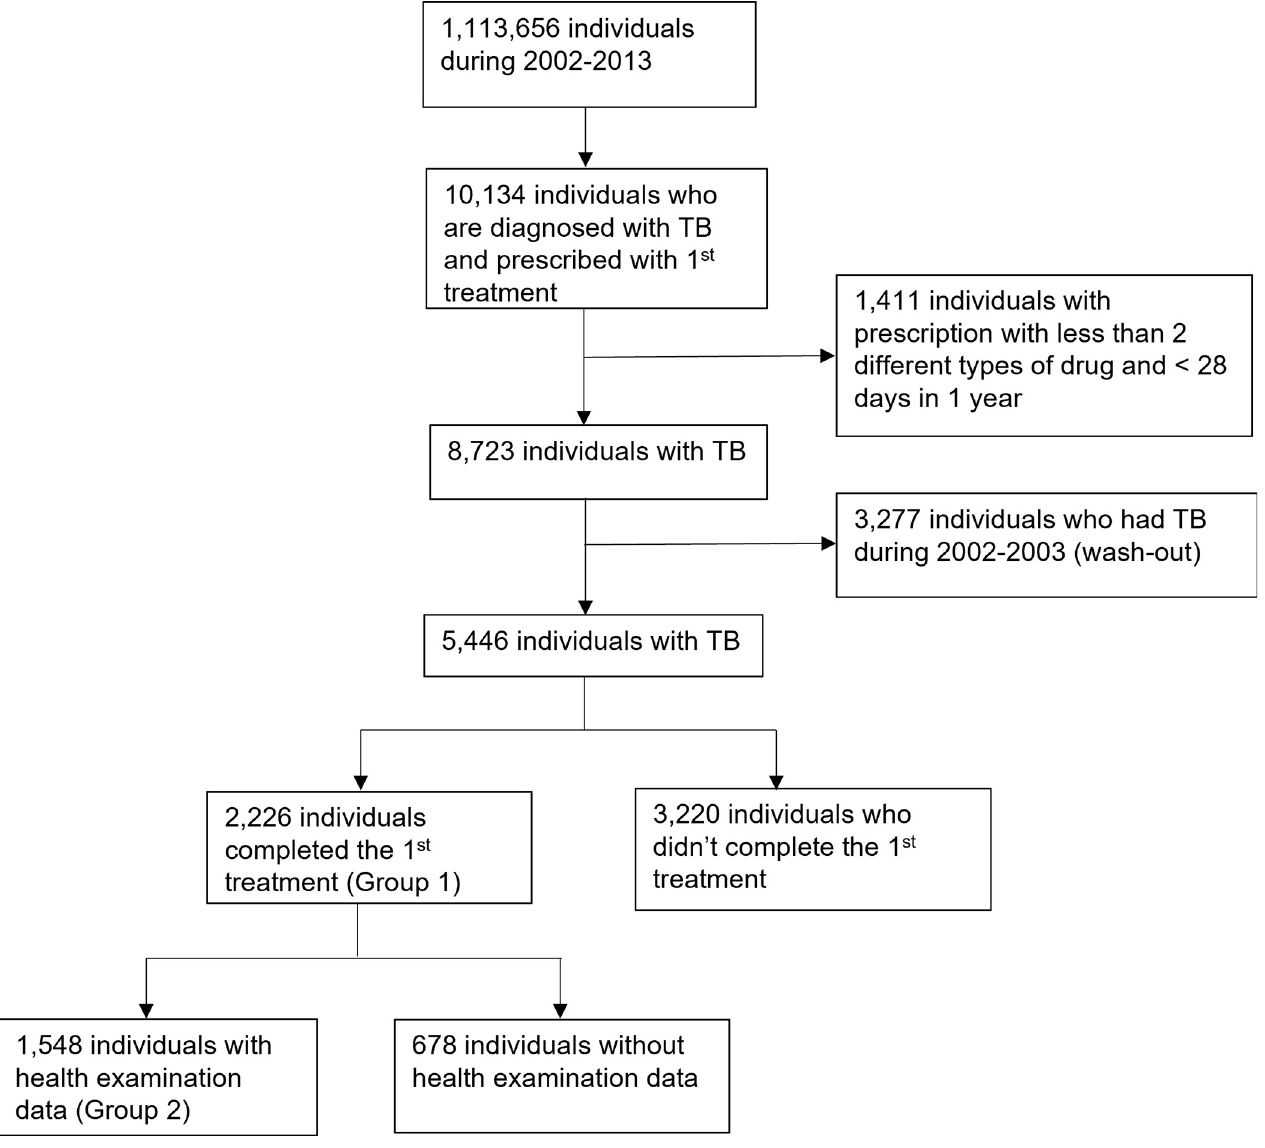
Fig 1. Flow diagram of the study